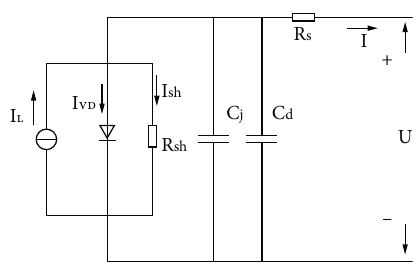
Figure 1: Equivalent circuit of a photovoltaic